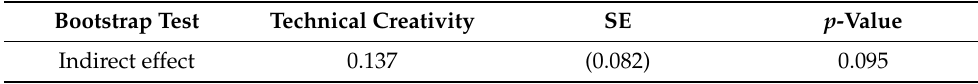
Table 7. Test of the technical creativity effect of the EPI on